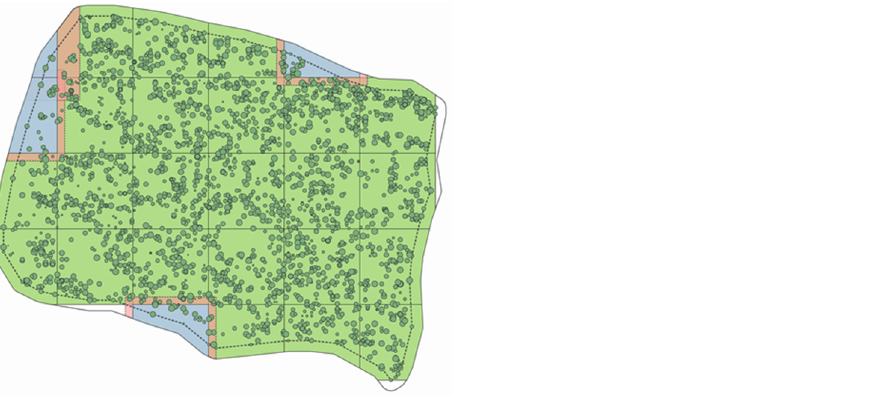
Figure 1. Distribution of harvested trees (dark green dots) within a delineated forest area. A buffer strip of 7 m was made around its perimeter and a grid of 50 m × 50 m was laid out over the area. The dot size reflects the estimated DBHOB of trees. Partial grid cells filled with light blue along the boundary were expanded at all sides (dark salmon strips) to contain at least 35 trees for the calculation of their stand attributes (see text).